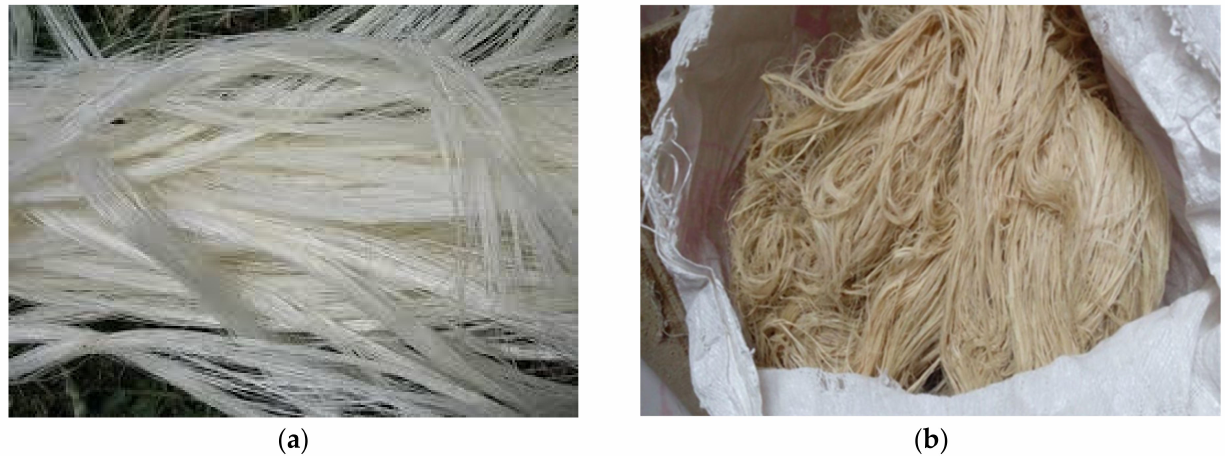
Figure 1. Sisal fibers ( a ) Caryota fibers ( b ) used for the fabrication of